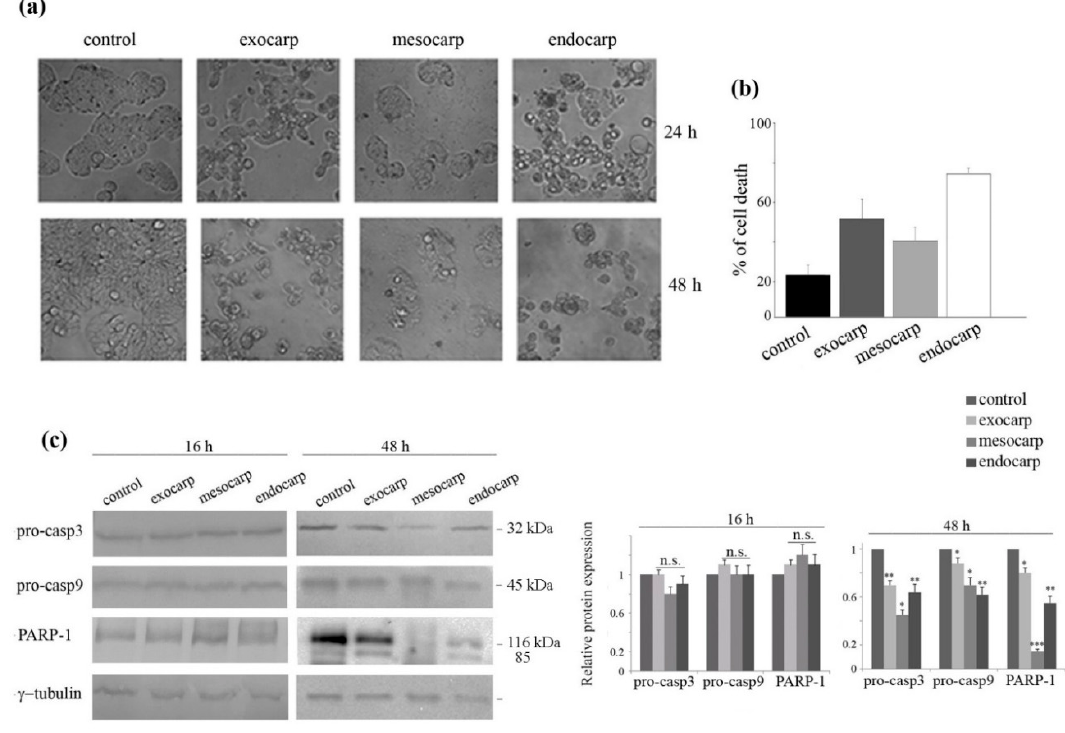
Figure 3. Apoptotic effects promoted by litchi fruit extracts in HT29 cells. ( a ) Morphological effects induced by litchi extracts in HT29 cells. The pictures were acquired after cell treatment with 150 µ g/mL GAE litchi extracts at the indicated times by a Leica light microscope (200 × magnification). ( b ) Detection of HT29 cell death. After 48 h of treatment, cells were incubated with an isotonic propidium iodide (PI) solution for 1 h and analyzed by flow cytometry using the Expo 32 software. The histograms indicate the percentage of PI-positive cells that reveal membrane permeabilization accounting for cell death. p value < 0.001. ( c ) Western blot analysis of apoptotic proteins evaluated after 16 h and 48 h of treatment. The correct protein loading was ascertained by immunoblotting for γ -tubulin. Representative blots of three independent experiments and densitometric analysis are shown. (*) p < 0.05; (**) p < 0.01; (***) p < 0.001; n.s. not significant.